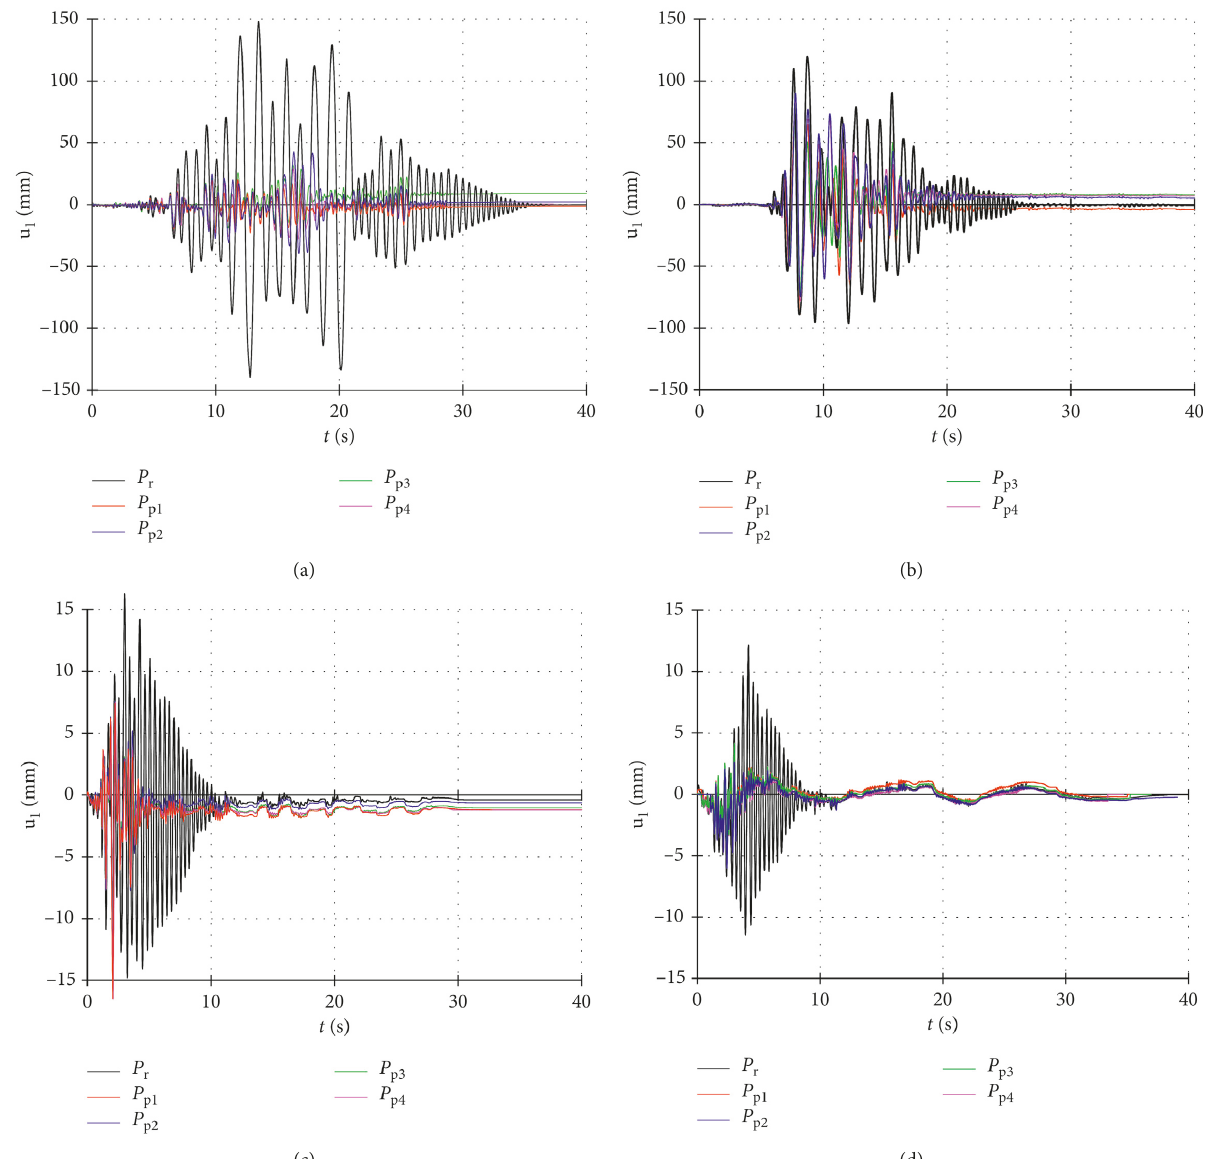
Figure 11: Horizontal displacement of the mass center at the column top ( u (AP). (c) Accelerogram Ston (AS). (d) Accelerogram B. Luka